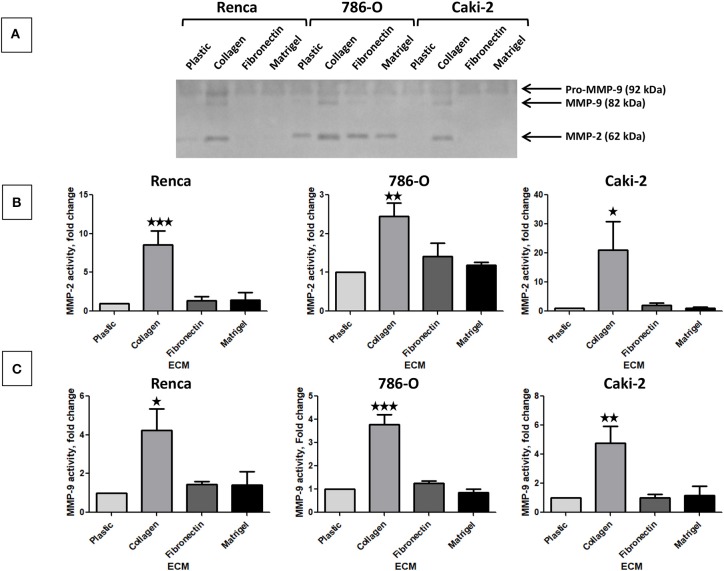
Effect of the different ECM components on active MMP-2 and MMP-9. (A) gelatin zymography was assessed on supernatants of RCC cells cultured on plastic, Col 1, FN1, or Matrigel for 24 h as indicated in materiel and methods. N = 4, a representative gel is presented. (B) quantification of active MMP-2 normalized to cell grown on plastic, N = 4. (C) quantification of active MMP-9 normalized to cell grown on plastic, N = 4. ⋆P < 0.05; ⋆⋆P < 0.01; ⋆⋆⋆P < 0.001.